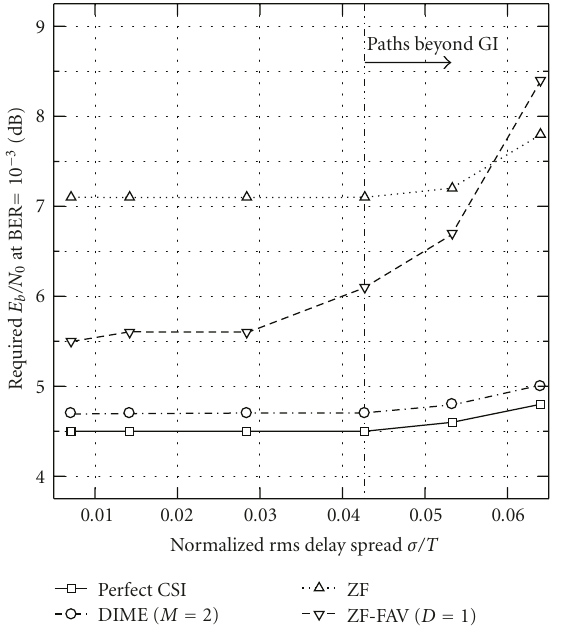
Figure 8: Required E b /N 0 performance versus normalized rms delay spread with f d T = 0 . 0075 (16-QAM-OFDM).